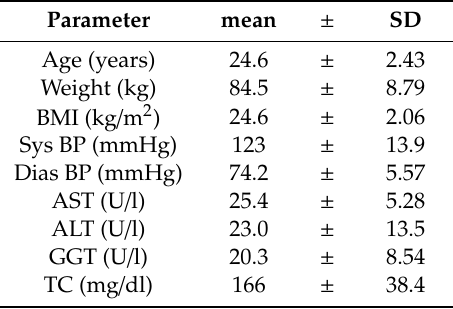
Table 2. Baseline clinical, biochemical, and anthropometric parameters of study participants. Shown are mean ± SD ( n =